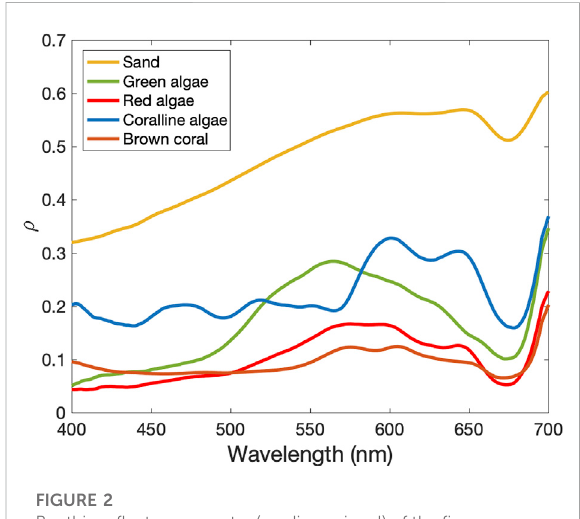
FIGURE 2 Benthic re fl ectance spectra ( ρ , adimensional) of the fi ve pure bottom cover classes: sand and mixture classi fi er which are: sand, green algae, red algae, coralline algae, and brown coral. Source: AdaptedfromMedeirosetal.(2018)andRoelfsemaandPhinn